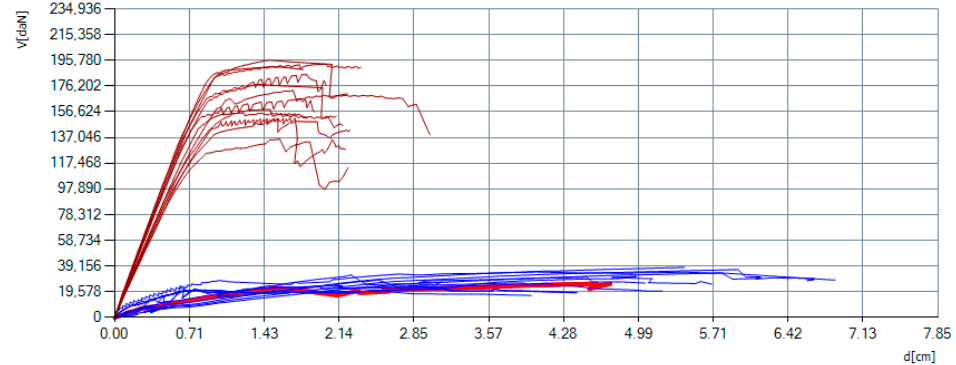
Figure 20. Cross-sections 1-1 and 2-2, Strengthening measures.